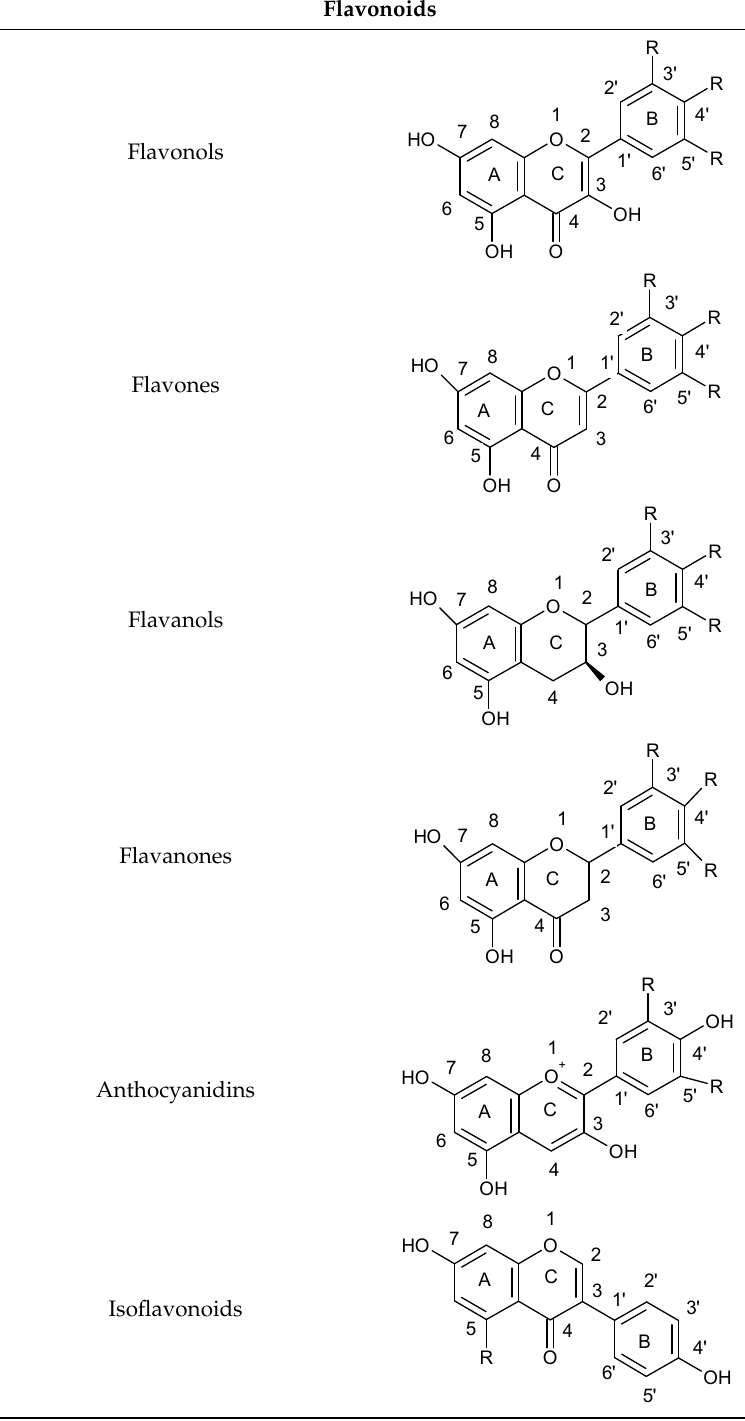
Table 1. Main classes of plant-derived polyphenols.